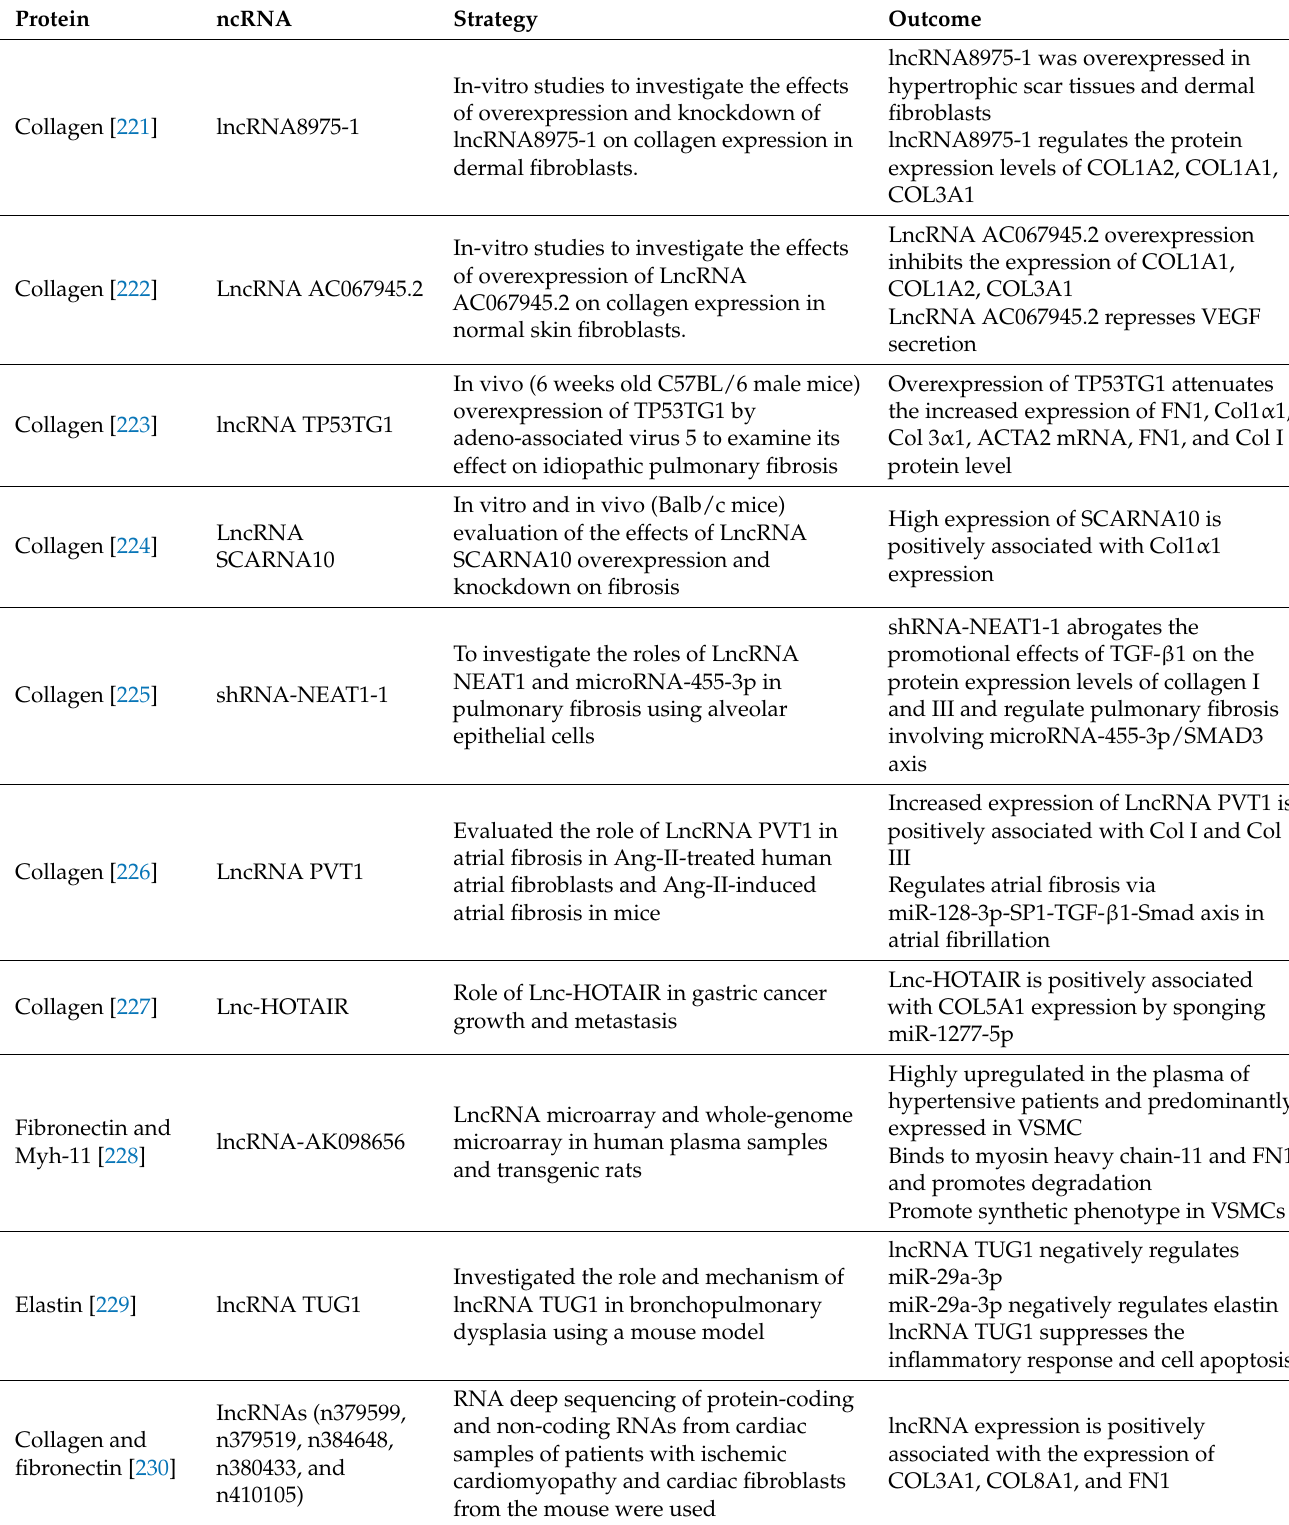
Table 4. Various ECM components regulated by